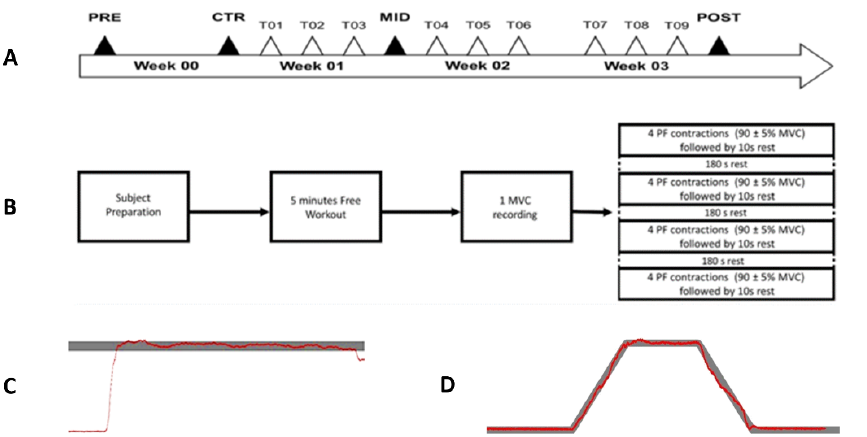
Figure 1. ( A ) Experimental design timeline including the experimental sessions (PRE, CTR, MID, and POST; black triangles) and training sessions (T; white triangles). ( B ) Progress of one training session. ( C ) Typical representation of the net torque feedback (N.m; red line) and target line (grey bar) as a function of time (s) during the training session. ( D ) Typical representation of the net torque feedback (N.m; red line) as a function of time (s) during one trial of the evaluation session.